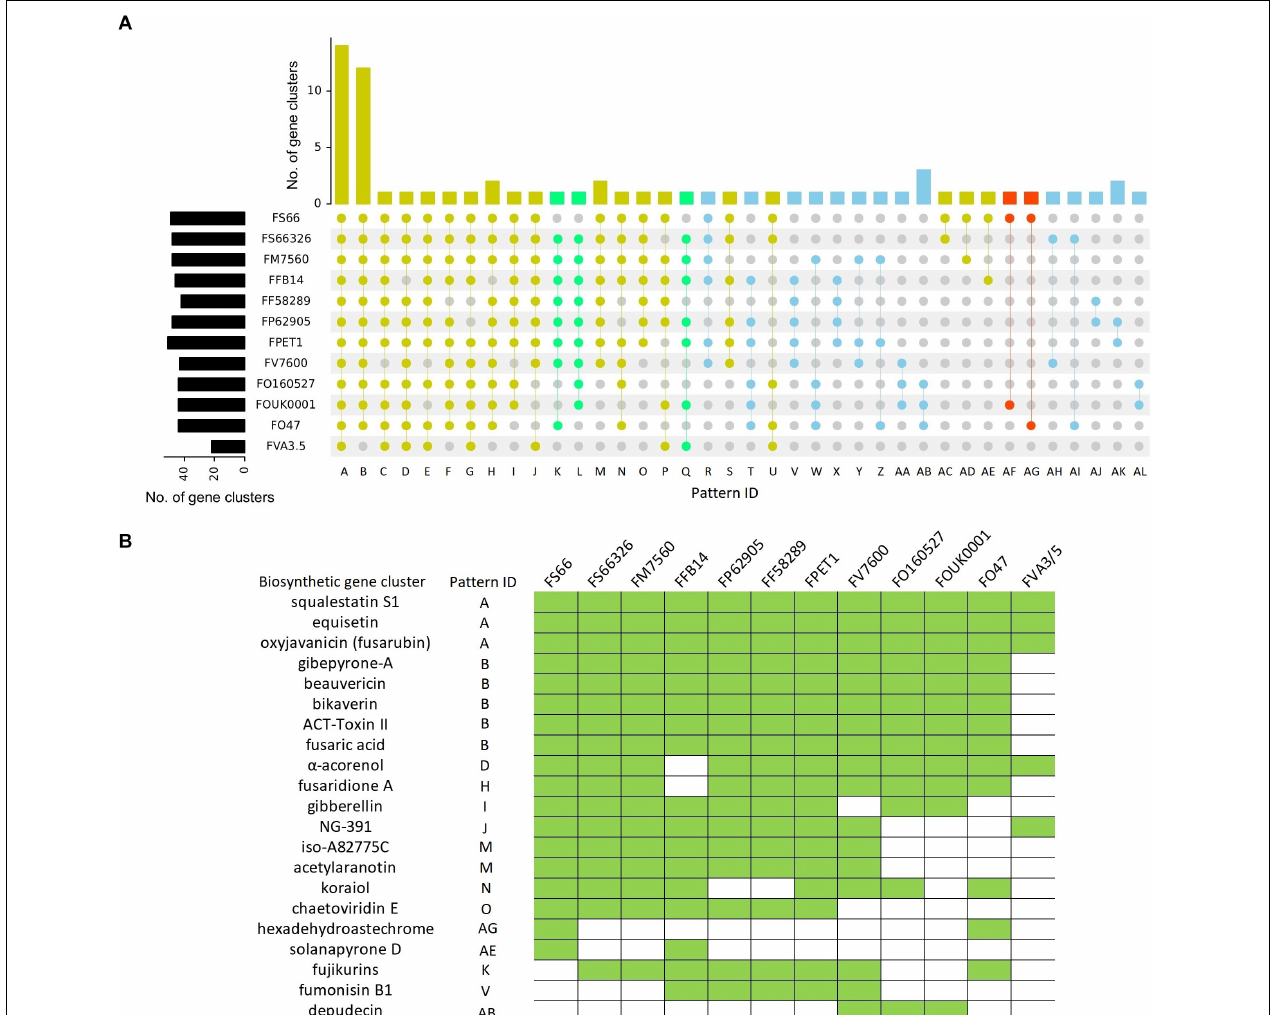
FIGURE 6 | Secondary metabolite gene cluster distribution in 12 Fusarium genomes. The isolates were named in the same way as in Figure 5 except for FVA3/5 in which ‘FV’ denotes F. venenatum . (A) Distribution of gene cluster sharing patterns among the 12 genomes in a total of 67 gene clusters. In the bottom panel, gray dots indicate absence, while colored dots (yellow, blue, red, and green) show the presence of the gene clusters in the corresponding genomes. The patterns in green color denote specific gene cluster loss in FS66, red denotes gene clusters putatively transferred from FOSC in FS66, yellow patterns include gene clusters present in more than 50% genomes, and blue pattern gene clusters were present in less than 50% genomes. (B) Availability of previously annotated gene clusters in the genomes. Green rectangles indicate the presence of the biosynthetic gene clusters in the corresponding